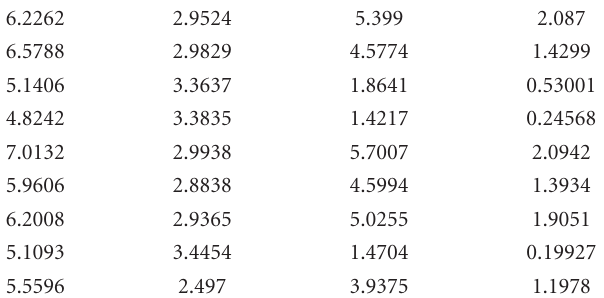
Table 5: Cluster centers using Iterative G-K algorithm, fuzzy hypervolume performance measure and up to 10